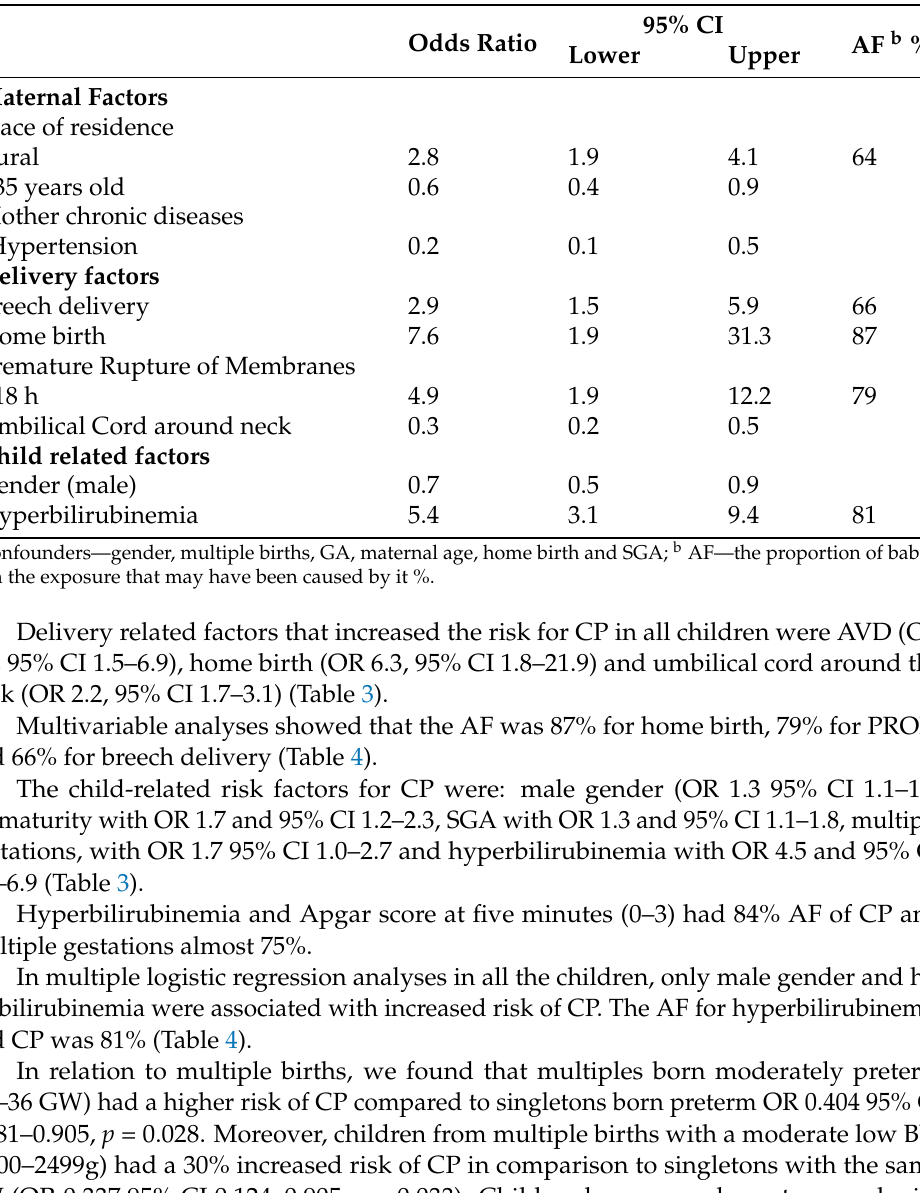
Table 4. Multivariable analyses a of the mother, delivery and child risk factors for cerebral palsy (CP), n =